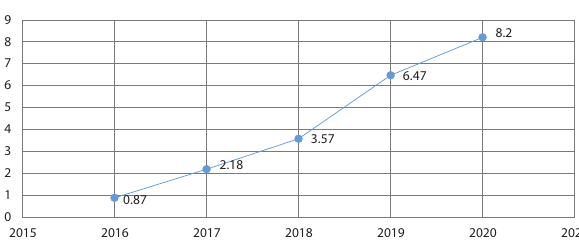
Figure 2. Net asset value of T-REIFs 2016–2020 (Capital Markets Board of Turkey, 2020)